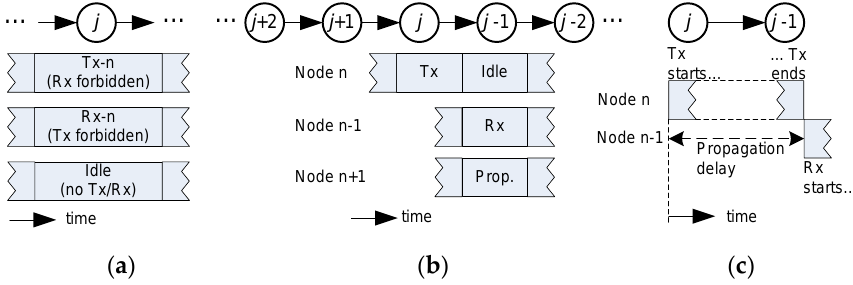
Figure 2. Network operation: ( a ) half-duplex operation means a sensor node can be in three states: transmission, reception, or idle; ( b ) omnidirectional propagation (with one hop power control): when node j transmits, the propagated wave reaches both nodes j + 1 and j − 1, but only node j − 1 receives the data (following the routing path); ( c ) the transmission time equals the propagation delay.